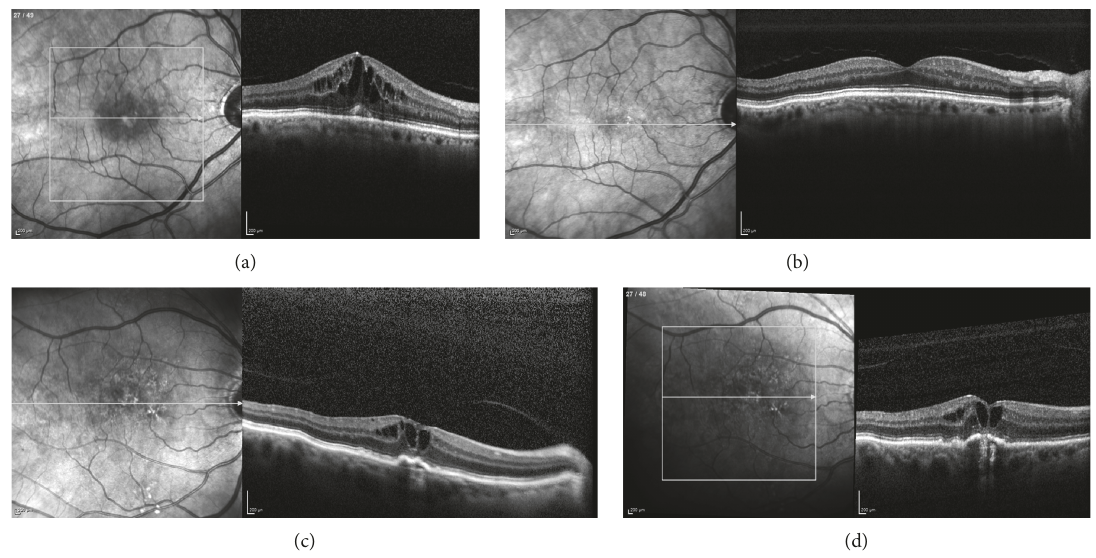
Figure 2: Optical coherence tomography (OCT) examples after DEX implant treatment success and treatment failure. (a) OCT image of a PCME patient (a massive macula edema with cyst, central retinal thickness 522 μ m) without diabetes and arterial hypertension before DEX implant therapy and (b) after DEX implant therapy (no longer either a macula edema or cyst, central retinal thickness 285 μ m). (c) OCT image of a PCME patient (a macula edema with cyst, central retinal thickness 384 μ m) without diabetes, but with arterial hypertension before DEX implant therapy and (d) after DEX implant therapy (a macula edema with cyst similar to pretreatment, central retinal thickness 370 μ